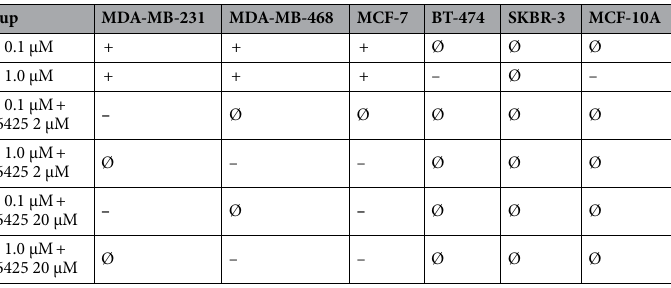
Table 5. Invasion assay. Effect of lysophosphatidic acid (LPA) 18:1 and the LPA receptor 1, 3 (and 2) inhibitor Ki16425 on invasion of different human breast (cancer) cell lines. n = 2 replicate experiments. Ø: no effect; +: stimulatory trend; –: inhibitory trend. For LPA 0.1 μM and LPA 1.0 μM stimulation was compared to the control group; for LPA 0.1 μM/LPA 1.0 μM + Ki16425 2/20 μM inhibition was compared to the respective LPA group without